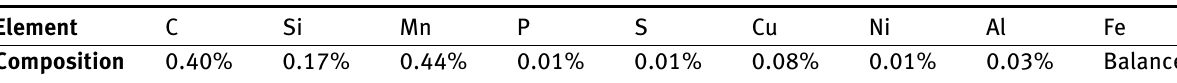
Table 1: Elemental content (wt. %) of LCS